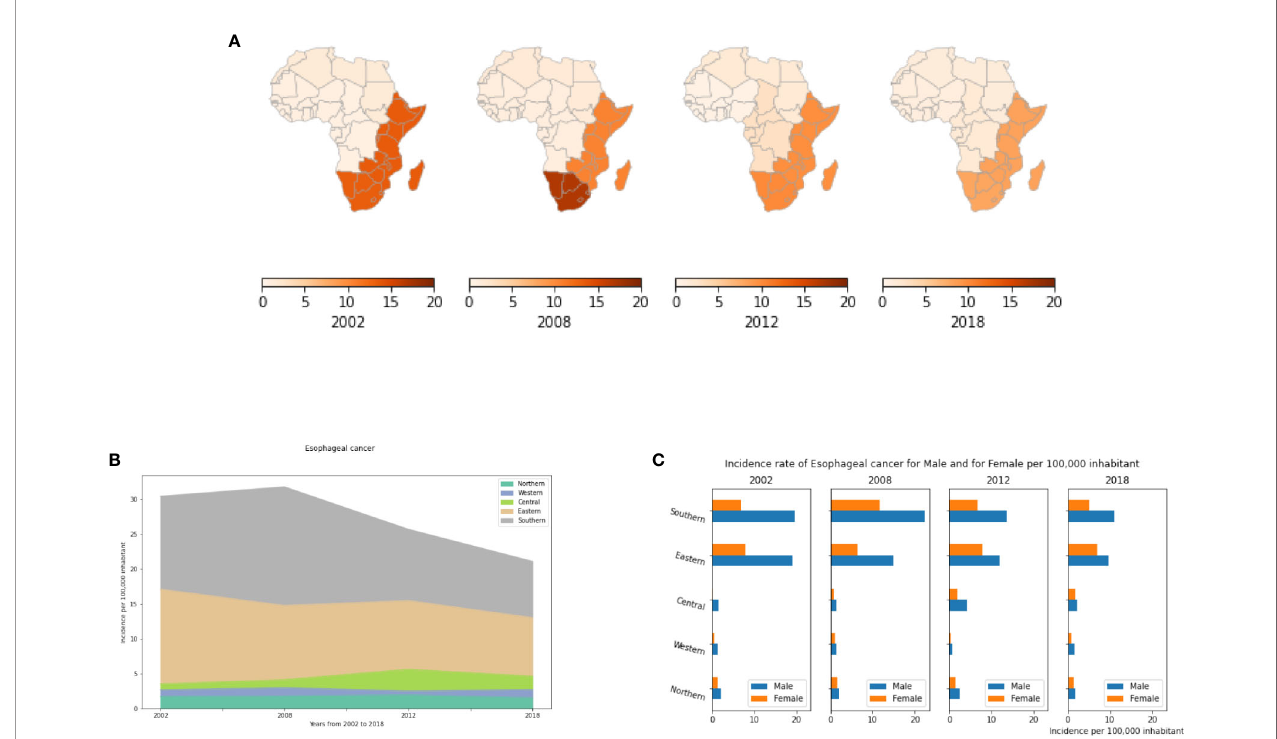
FIGURE 7 | Esophageal cancer incidence rates per year, by African region and by gender. (A) Esophageal cancer incidence per 100,000 inhabitant in African regions. (B) Dynamics of incidence rates from 2002 to 2018. (C) Esophageal cancer incidence by